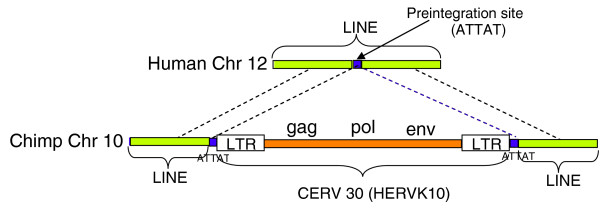
Insertion of a member of the CERV 30 (HERVK10) family in chimps. The insertion occurred in the LINE element present in chromosome 10 of the chimpanzee genome. The orthologous LINE element is present in chromosome 12 in humans. In chimpanzees target site duplications (ATTAT) are identified. A single copy of TSD (ATTAT, the pre-integration site) is found inside the LINE element in humans. The LTRs of the element are 99.4% identical.